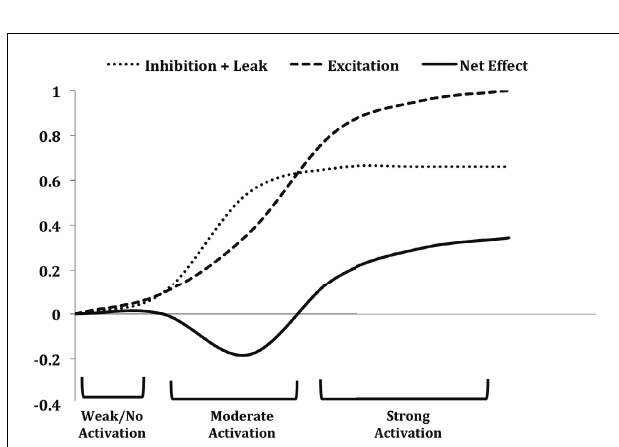
FIGURE 8 | Chip data illustrating contrast enhancement. (A) An odor with a constant concentration was presented at the 200-ms time point, and persisted till the 500-ms time point (solid black line). As an illustration, the spiking activity (vertical bars) of seven mitral cells in response to the odor is shown.The mitral cells receiving input from OSNs that most strongly respond to the odor exhibit increased activity whereas those receiving input from weakly responsive OSNs are inhibited below baseline, such that they are less active even than completely insensitive mitral cells (see Figure 9 ).The activity patterns of the mitral cells shown are presented in a one-dimensional, two-tailed chemotopic arrangement for illustrative purposes; see Cleland and Linster (2012) for a high-dimensional illustration.The mitral cell depicted in the